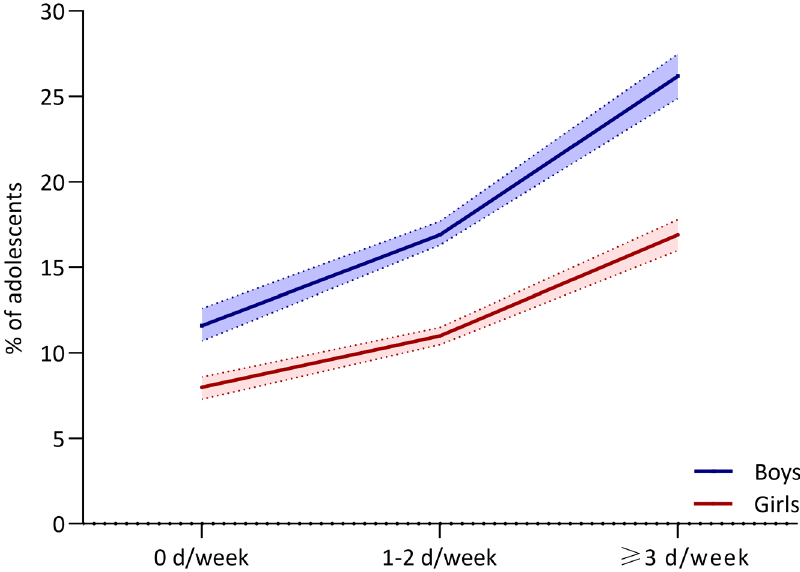
Figure 1. Proportion of adolescents sufficiently physically active by participation in physical education classes, Global School-based Student Health Survey,